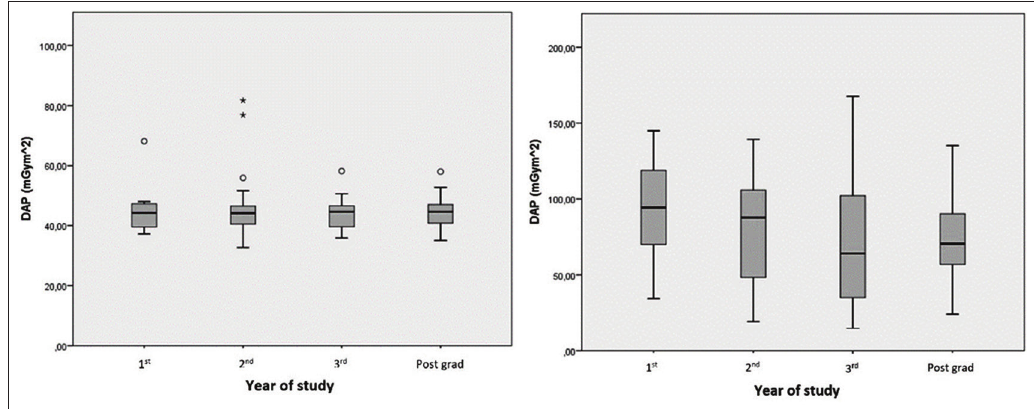
FIGURE 3. Dose area product comparison between study years for anteroposterior view (left) and lateral view (right) of useful images of the lumbar spine.